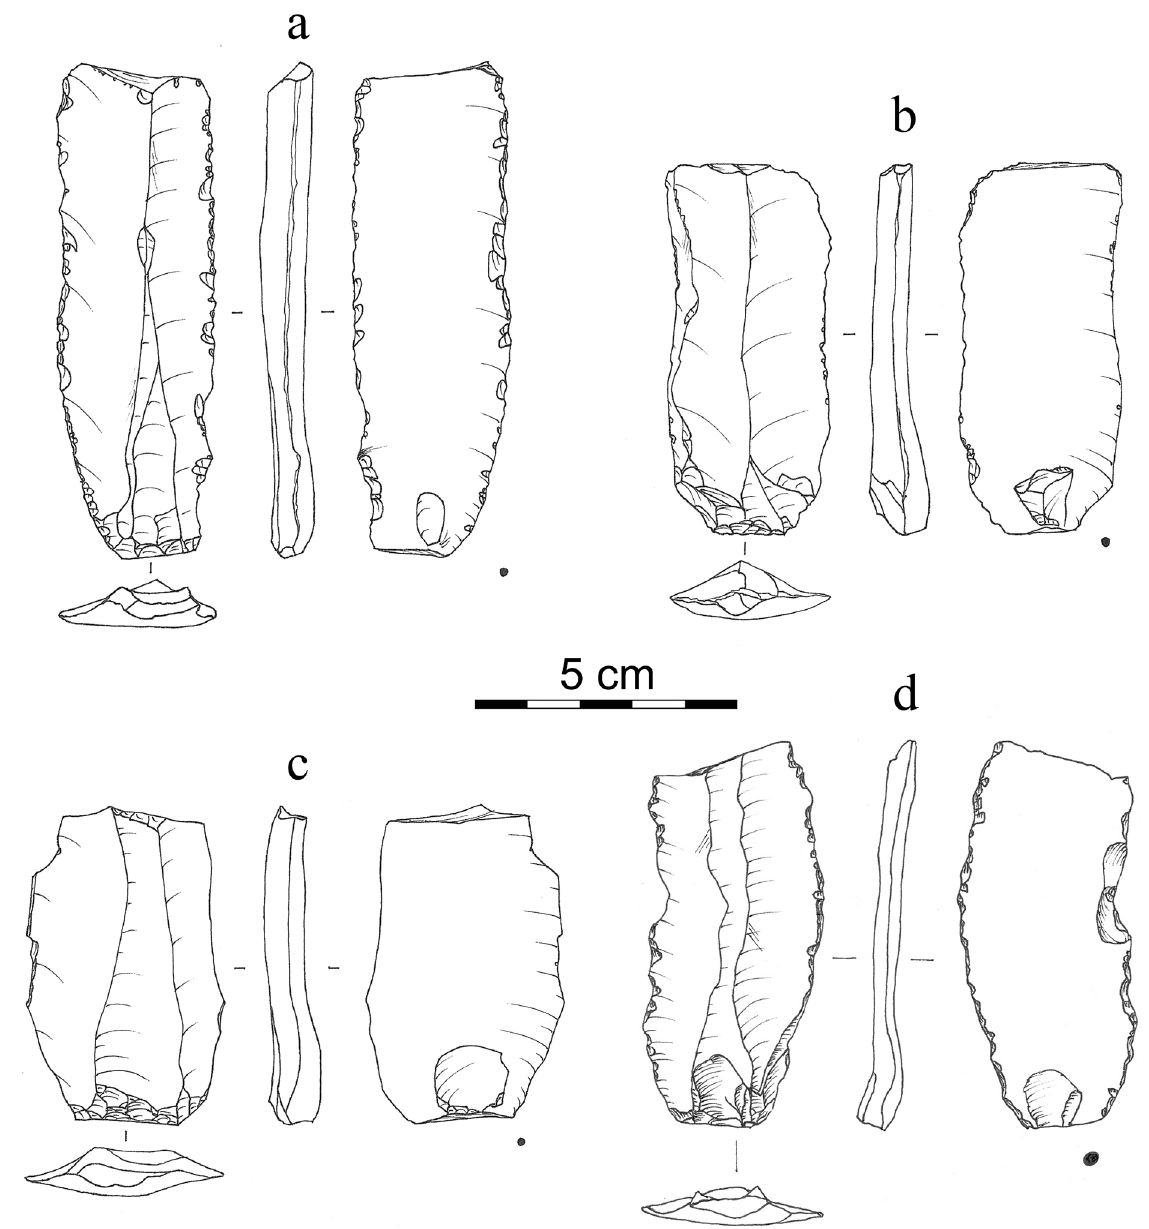
Figure 5. Tronçons de lames d’Aknashen fabriqués par percussion indirecte. Figure 5. Segments of blades from Aknashen knapped by indirect